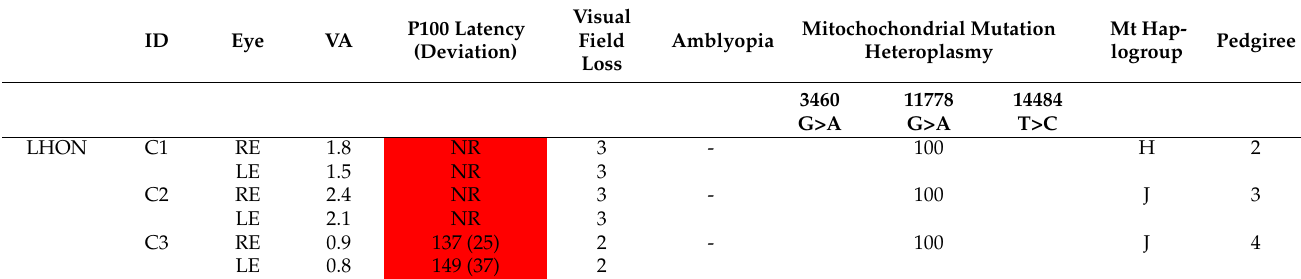
Table 4. Optic nerve function including logMAR visual acuity, P100 latency and visual field loss, and mitochondrial mutation, heteroplasmy and haplogroup, and pedigree, in LHON and asymptomatic maternal carrier relatives is shown. The P100 latency is given in milliseconds (ms), with deviation from mean normal value (112 ms) to above 128 ms, or non-recordable (NR), or interocular difference greater than 10 ms highlighted in red as delayed, or if normal is highlighted in green. Amblyopia is reported as present (+) or absent (-).